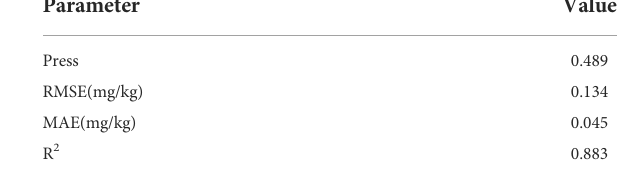
TABLE 5 Detection results of the validation